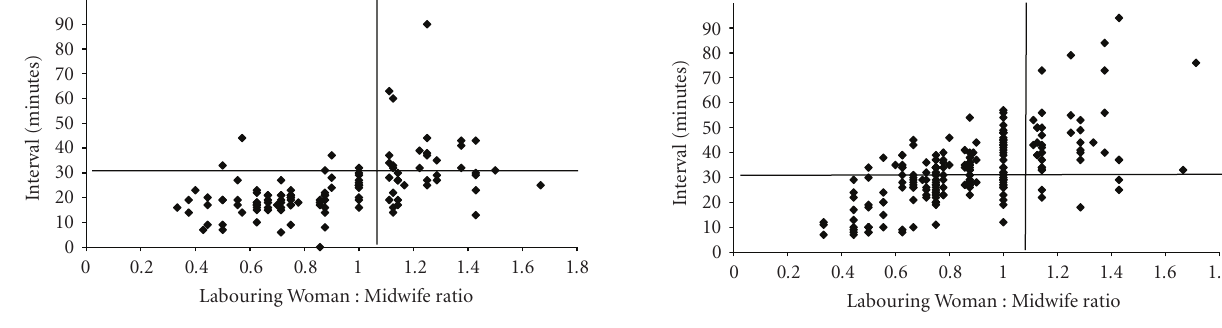
Figure 4: Decision-to-delivery interval versus Labouring Woman: Midwife ratio (grade 1).